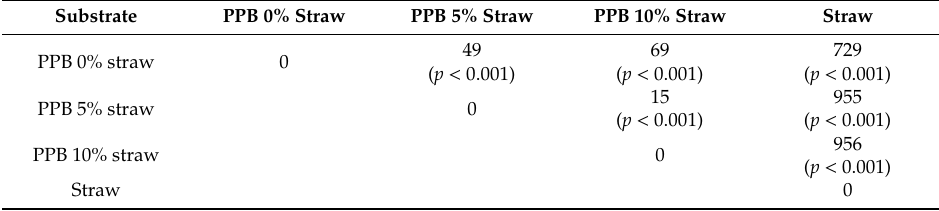
Table 4. Canonical discriminant analysis: Mahalanobis quadratic distances.